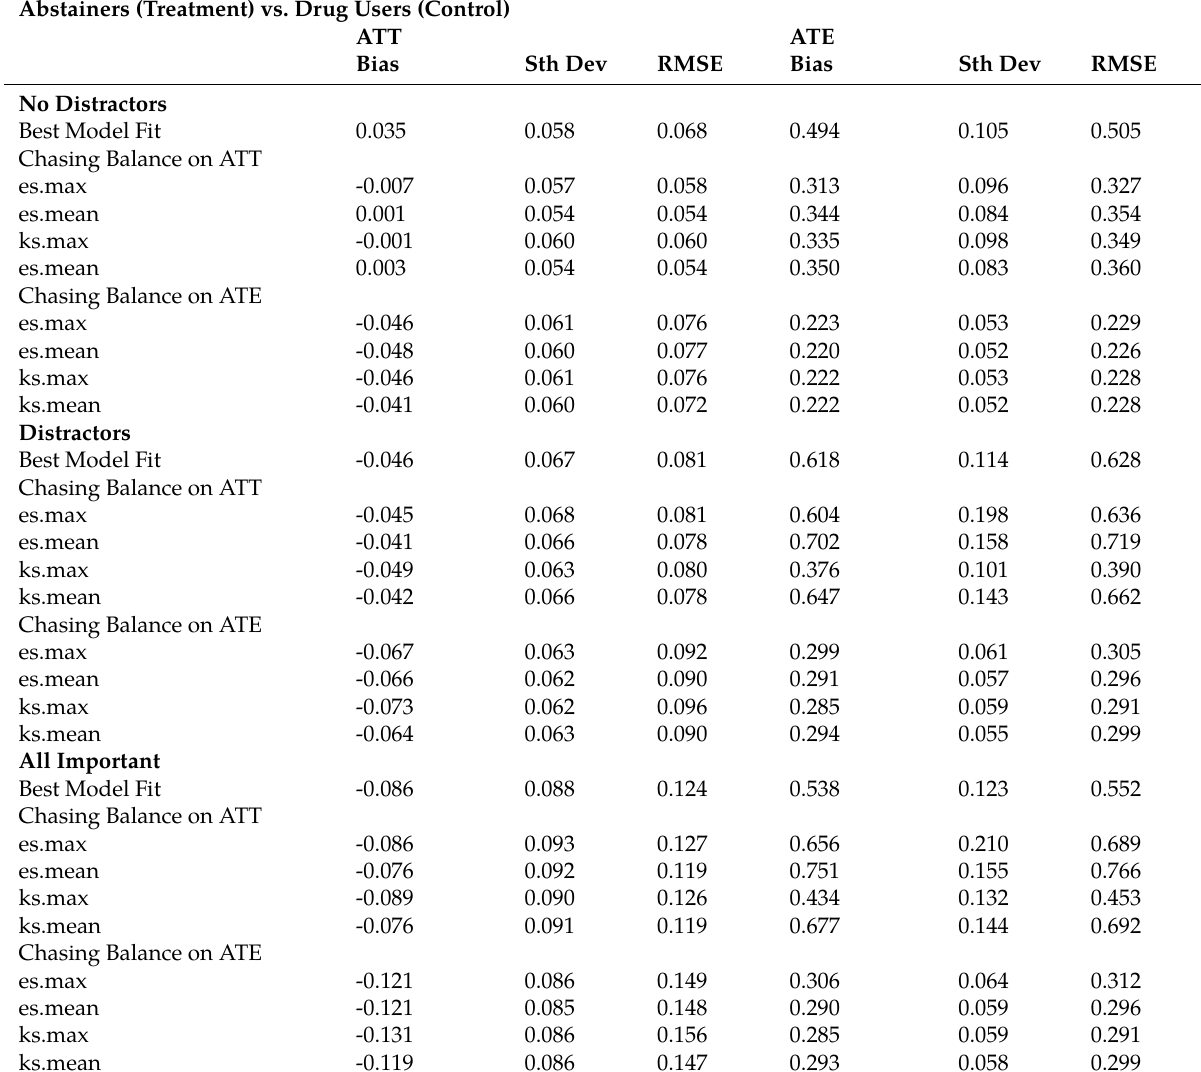
Table 5: Summary Statistics for Treatment Effect Estimates for all stopping rules and methods considered for the abstainers ’ example